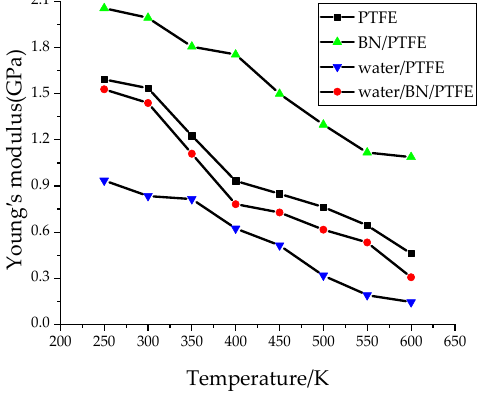
Figure 4. Young’s modulus versus temperature.